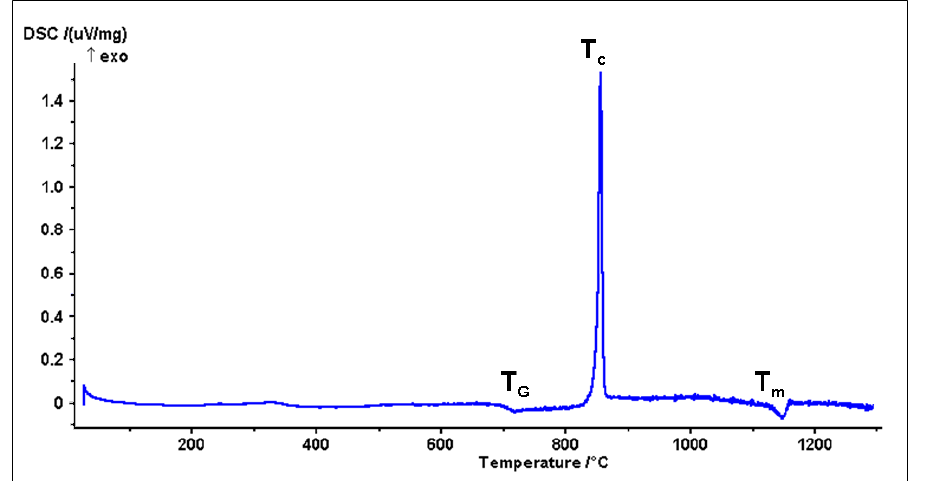
Figure 1. Differential thermal analysis of the BG_Ca glass (heating rate 10